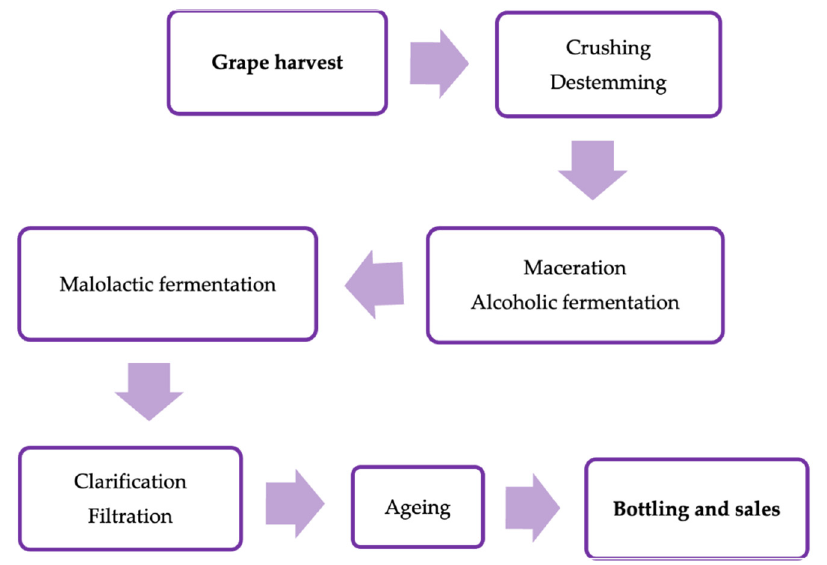
Figure 1. Flow sheet of vinification process.